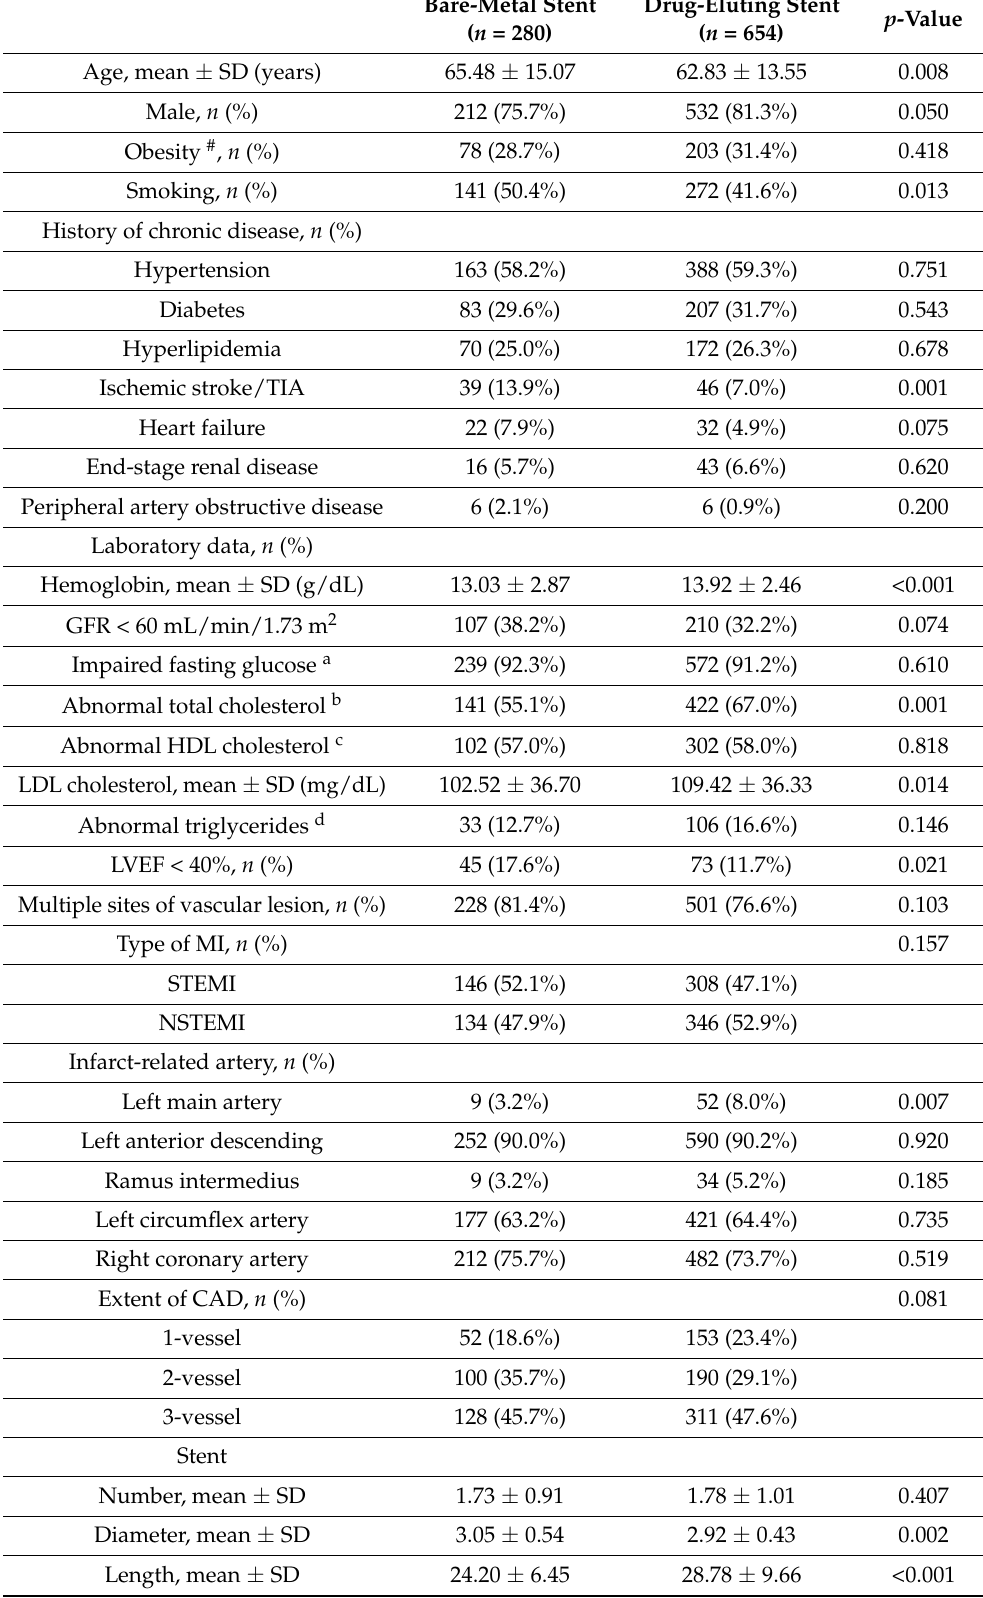
Table 1. Basic demographic